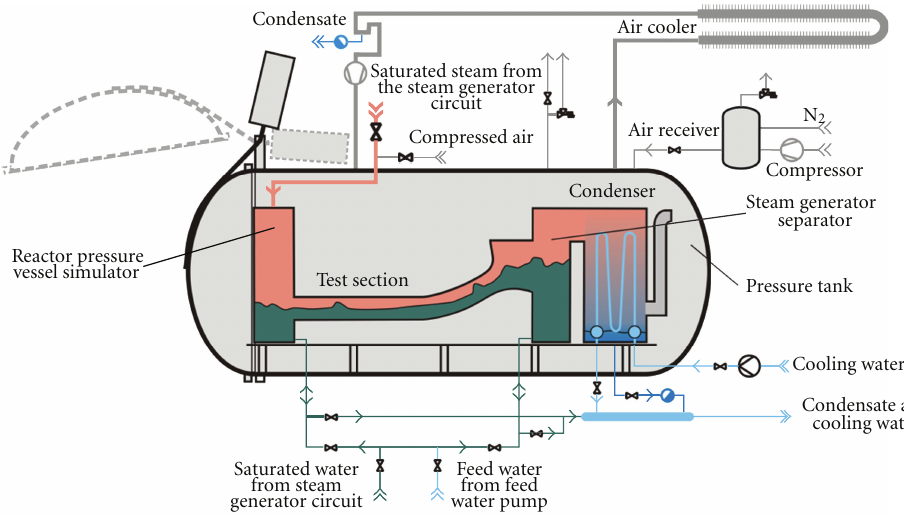
Figure 3: Schematic diagram of the experimental